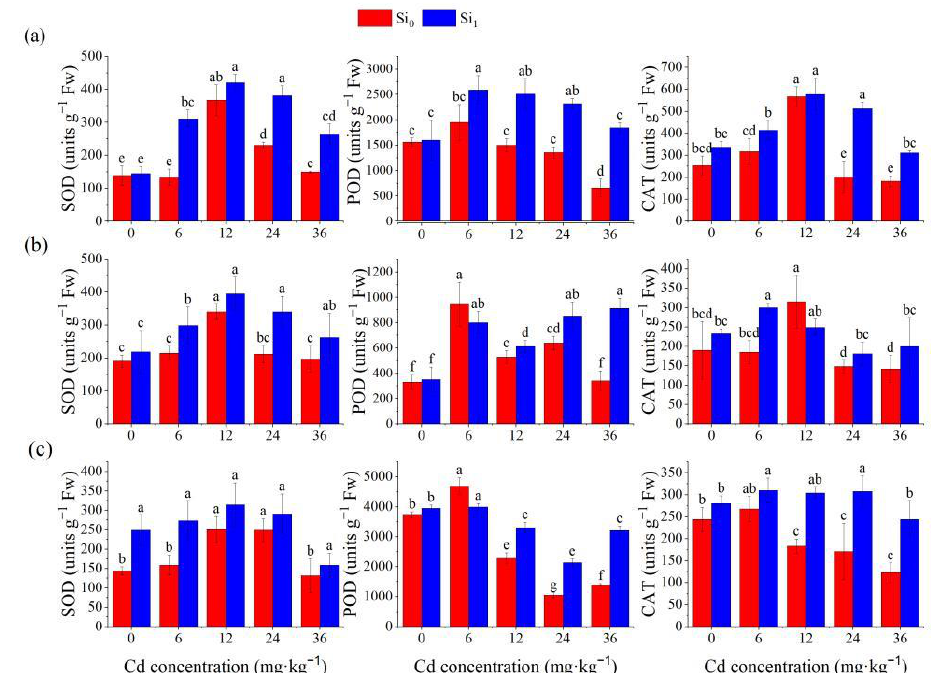
Figure 2. Effects of Cd and Si on antioxidative enzyme activities of seedlings for ( a ) Schima superba , ( b ) Chinese sweetgum, and ( c ) Chinese fir. Each value is a mean of six repetitions. Lowercase letters above the bars indicate significant differences according to the Turkey’s test ( p < 0.05).